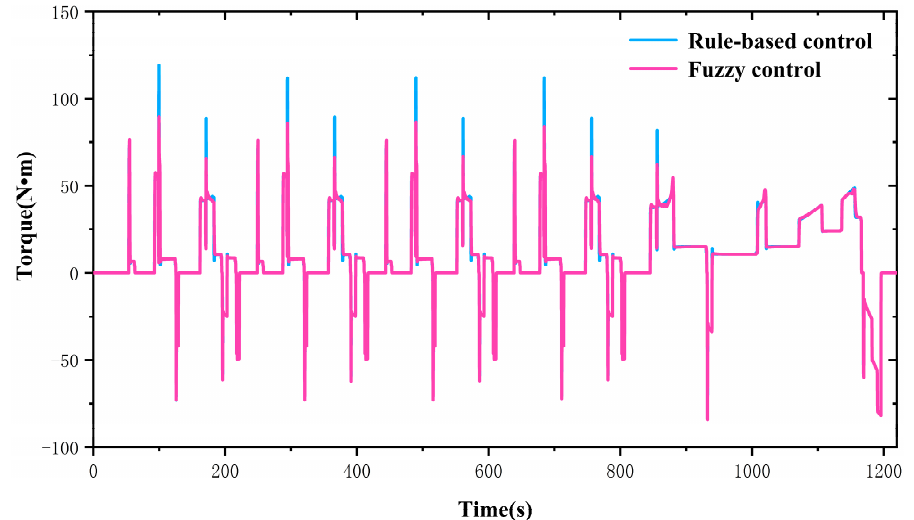
Figure 13. Fuzzy optimization analysis: torque curve.